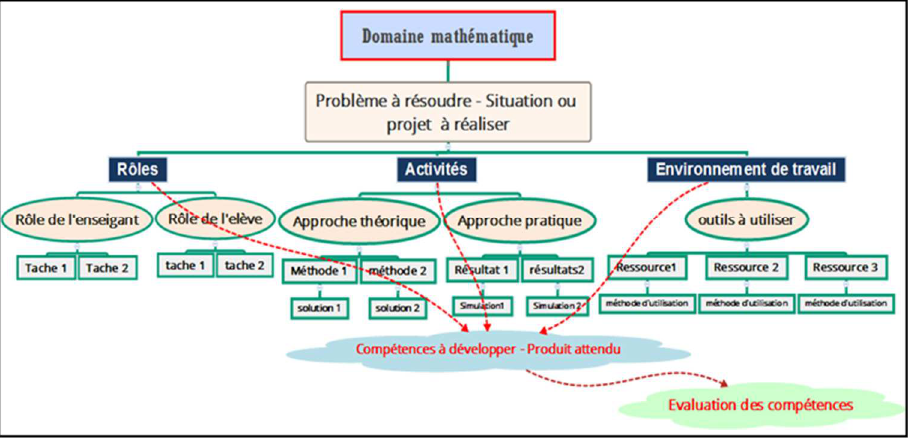
Fig. 3. Processus de scénarisation d’un problème ou situation lié à un domaine